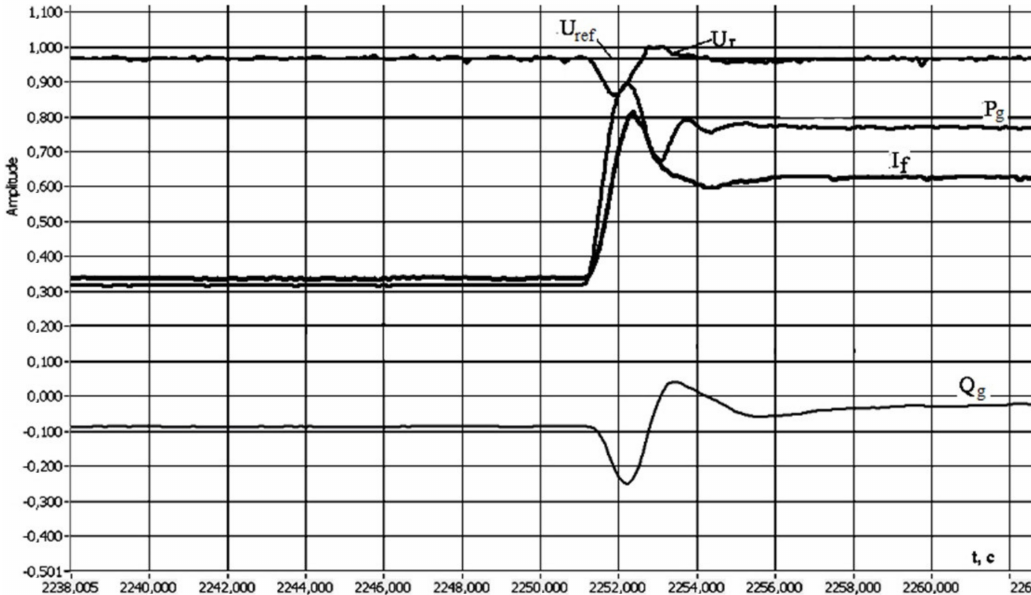
Figure 3. The mode of the initial excitation of the generator without load.